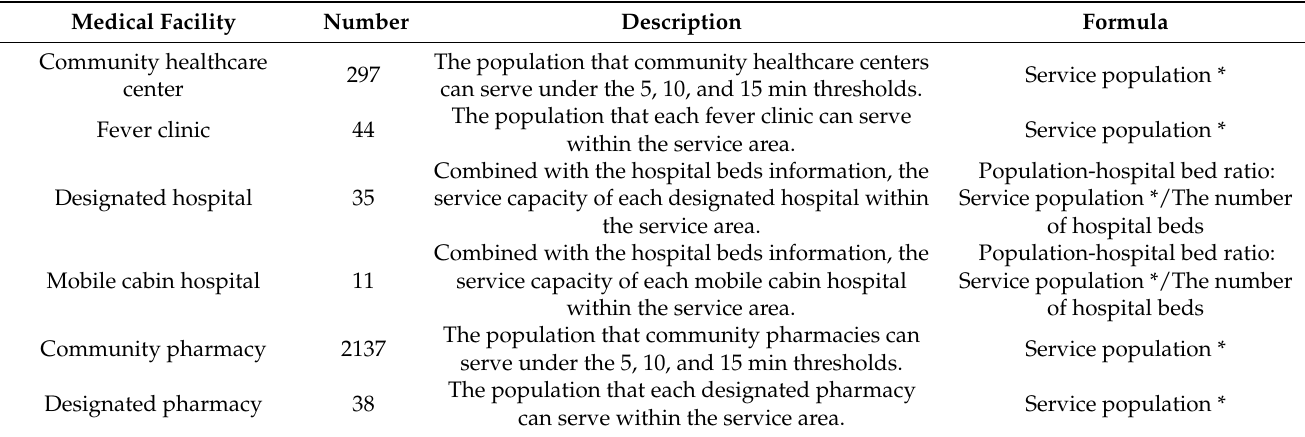
Table 1. The potential capacity indices of various medical facilities.